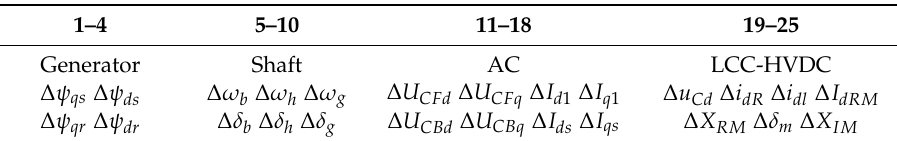
Table 3. State variables of the entire